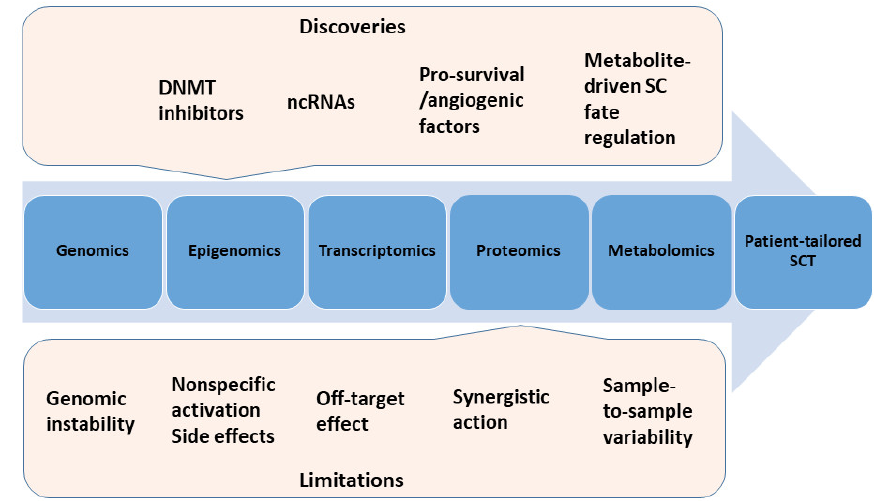
Figure 1. Integrating panomic data in stem cell therapy. Discoveries and limitations have been identified for each category of omic data. Findings that stem cell (SC) fate can be regulated by various factors (such as DNMT inhibitors, ncRNAs, pro-survival or angiogenic factors, and metabolites) provided useful tools to improve cardiac regeneration and achieve patient-tailored therapy. Conversely, there are shortcomings of their use into clinics. Cultured SCs are prone to genomic alterations that affect their differentiation potential and tumorigenicity. The use of DNMT inhibitors is limited by hindered by off-target effect due to their ability to regulate genetic networks and not a single